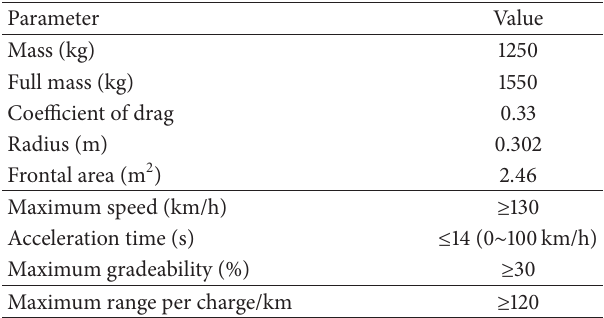
Table 2: Parameter of electric vehicle. Table 3: Powertrain parameter of electric